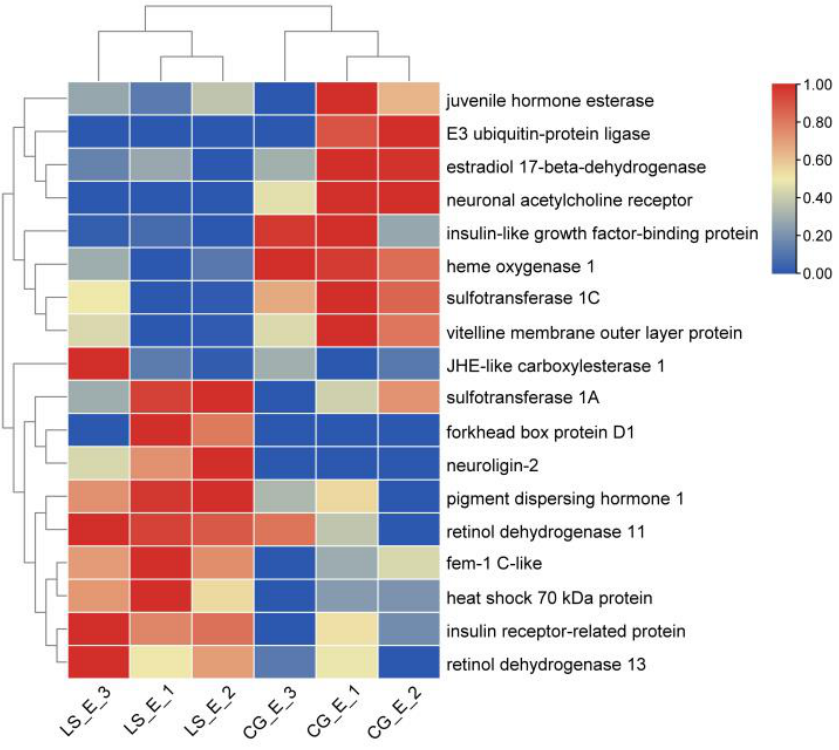
Figure 7. The heatmap of DEGs related to ovarian development in the LS _ E vs. CG _ E group.